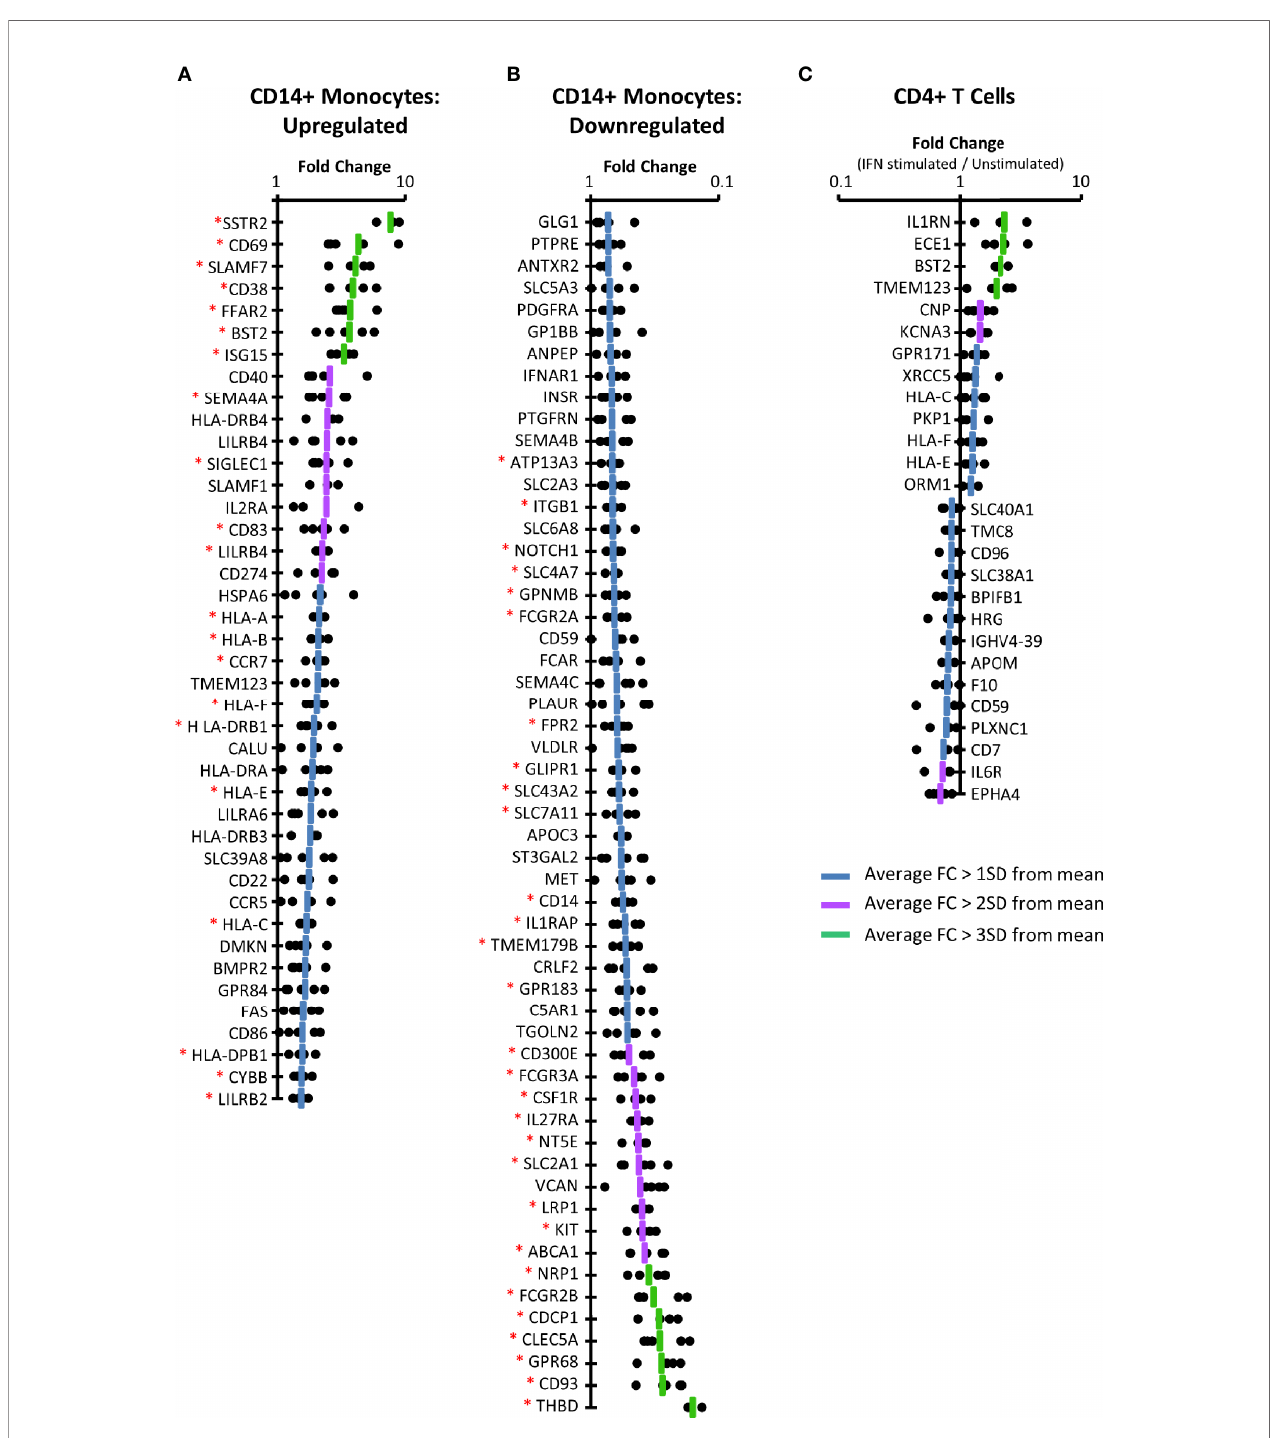
FIGURE 3 | IFN a 2a-induced changes at the PM of CD14+ monocytes and CD4+ T cells. (A) Proteins consistently upregulated by IFN a 2a in primary CD14+ monocytes (FC > 1SD from the mean, with FC > 1 in all donors). Dots display the fold change for each donor, and the line represents average FC. Data for all proteins upregulated >1 SD above the mean, prior to fi ltering for consistent upregulation is shown in Figure S3 . A Benjamini-Hochberg-corrected paired, two-tailed t-test was used to estimate the p-value that each protein exhibited signi fi cant change in expression upon IFN a stimulation (*p<0.05). The complete dataset is given in Tables S1 and S4B . (B) Proteins consistently downregulated by IFN a 2a stimulation in primary monocytes, determined as in (A) (FC > 1SD from the mean, and FC<1 in all donors). The complete dataset is given in Tables S1 and S4C . (C) Proteins consistently up- or downregulated in primary CD4+ T cells, as described in (A, B) . The complete dataset is given in Tables S1 and S4F, G